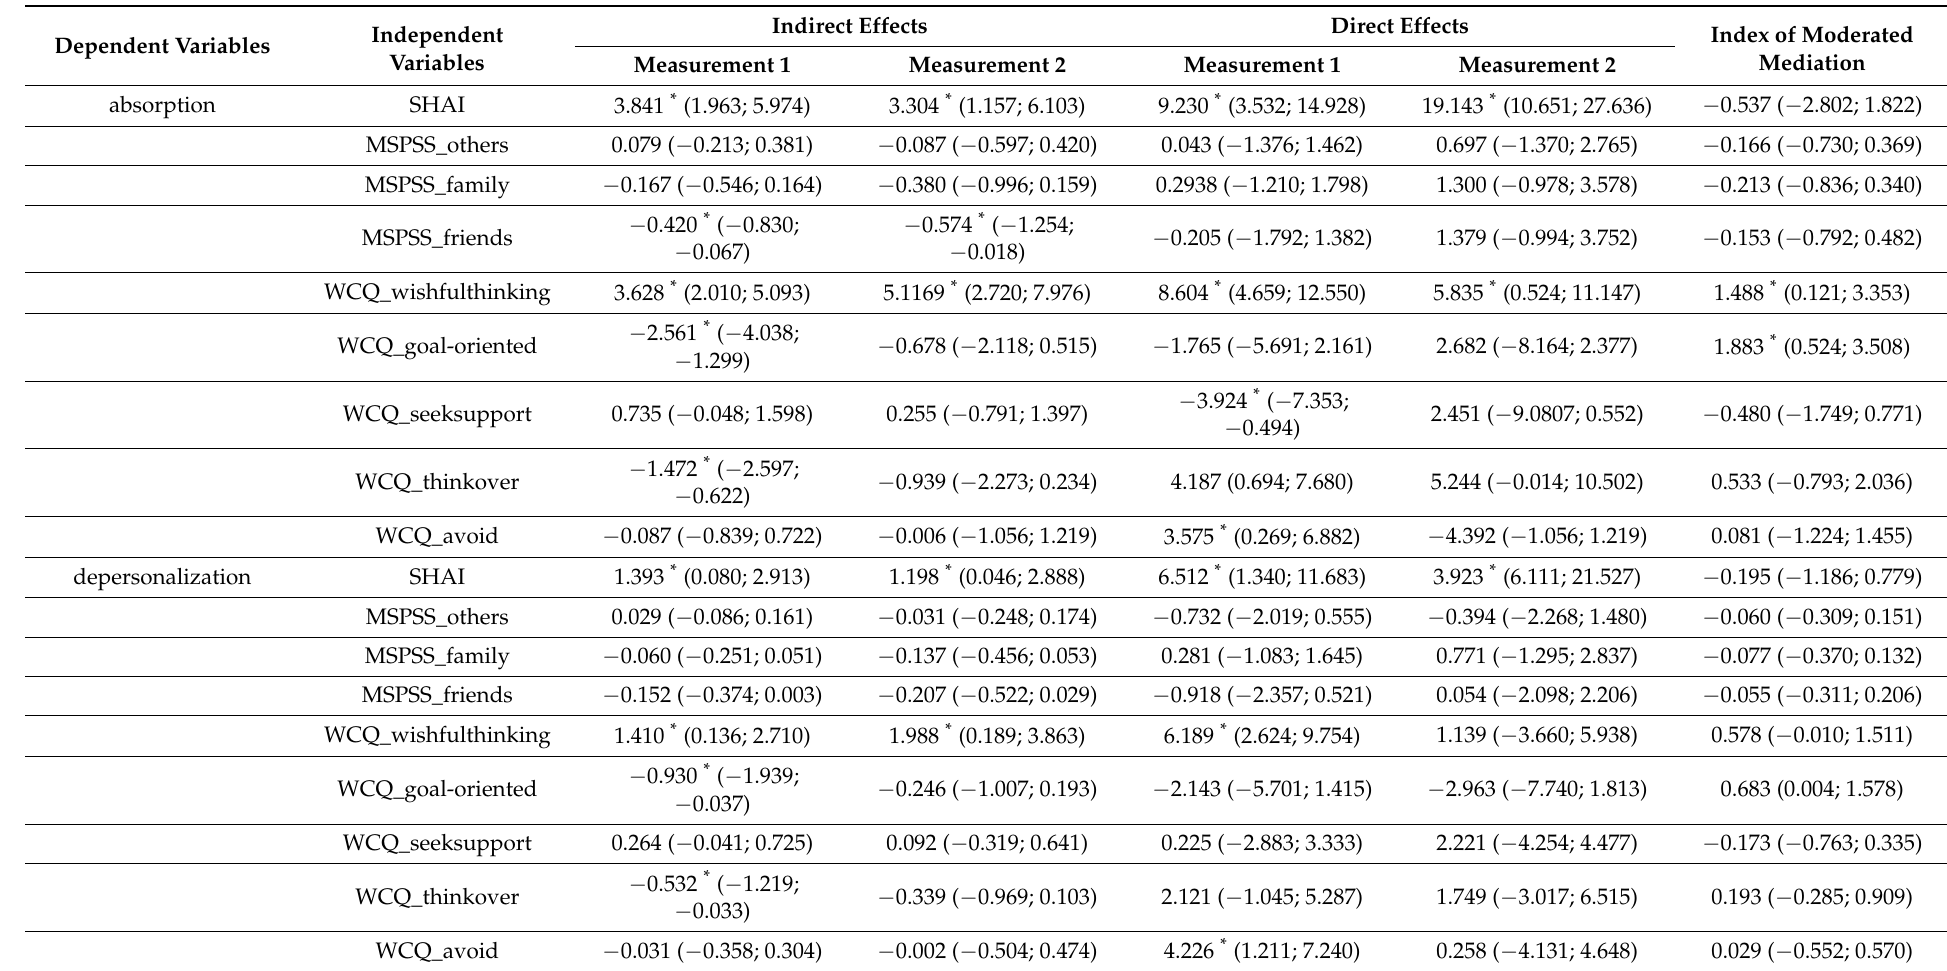
Table 7. Coefficients of the linear regression of the Hungarian